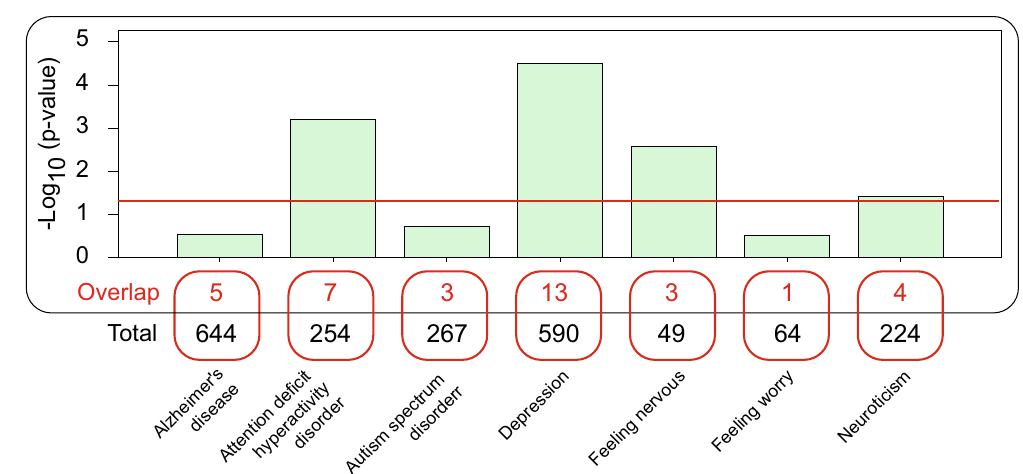
Figure 6. Overlap between murine candidate genes associated with anxiety and genes associated with human anxiety-related phenotypes and neuropsychological disorders. The overlap between mouse anxiety associated genes and genes associated with Alzheimer’s disease, attention deficit hyperactivity disorder, austism spectrum disorder, depression, feeling nervous, feeling worry and neuroticism. The red line indicates significant overlap